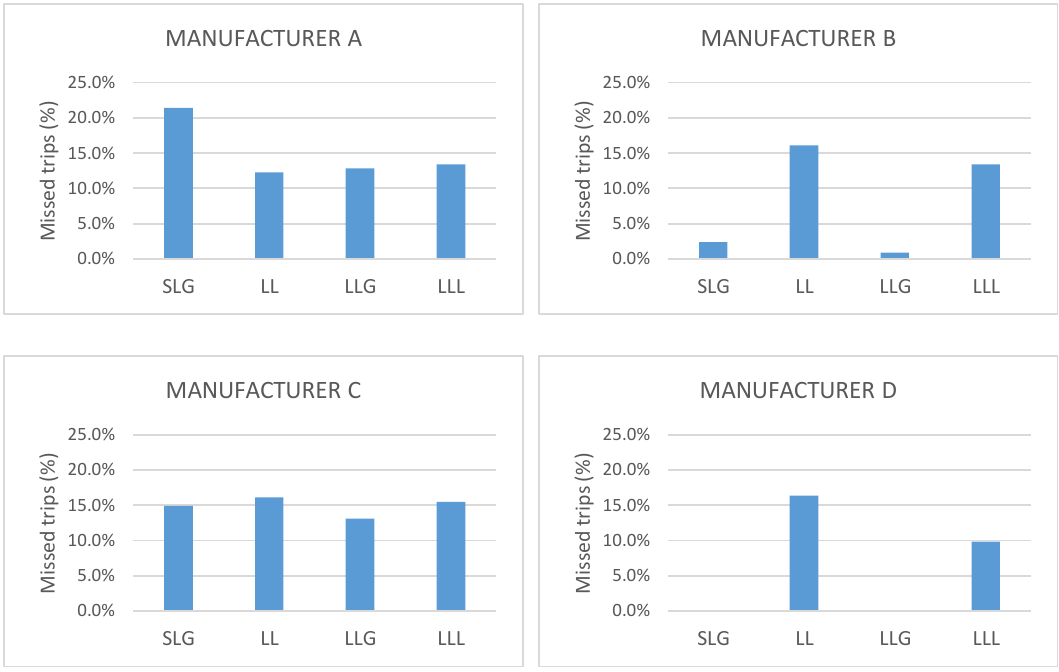
Figure 4. Distribution of missed trips between different types of faults for the four different vendors (percentage of missed trips over the total number of faults) for 100% renewables scenario for PV generator.